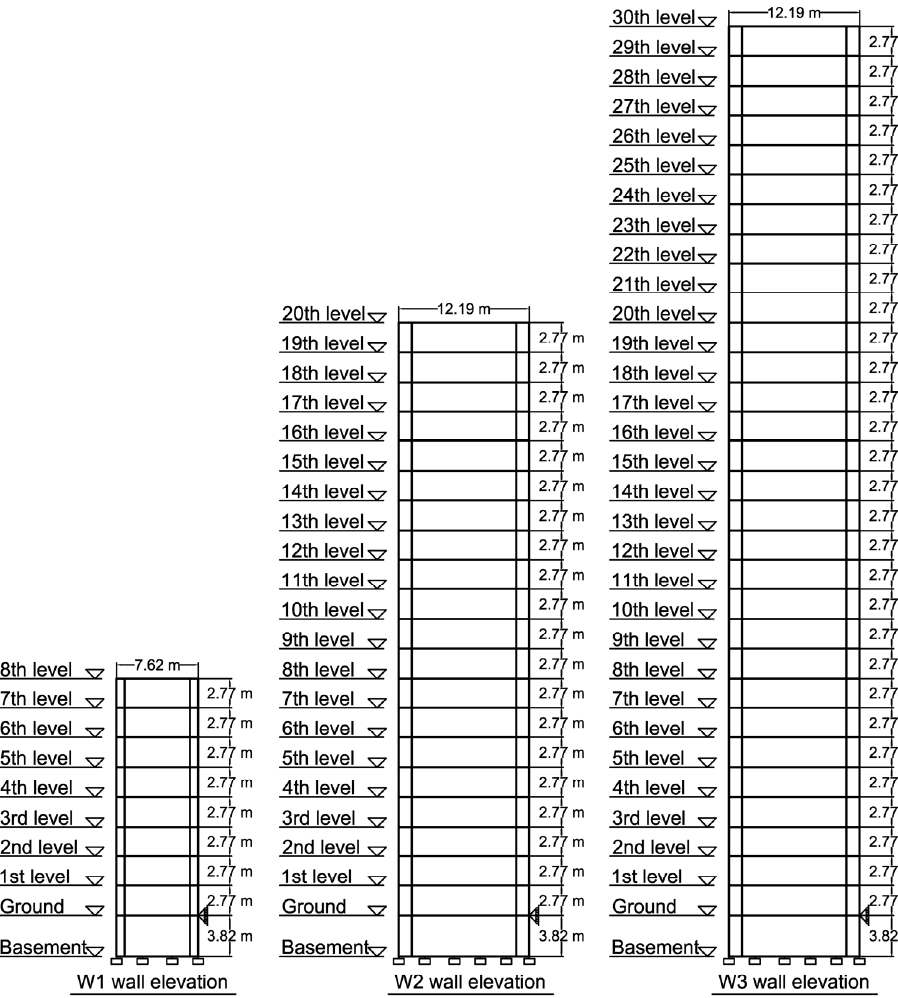
Figure A1. Elevation and plan views of wall structures.